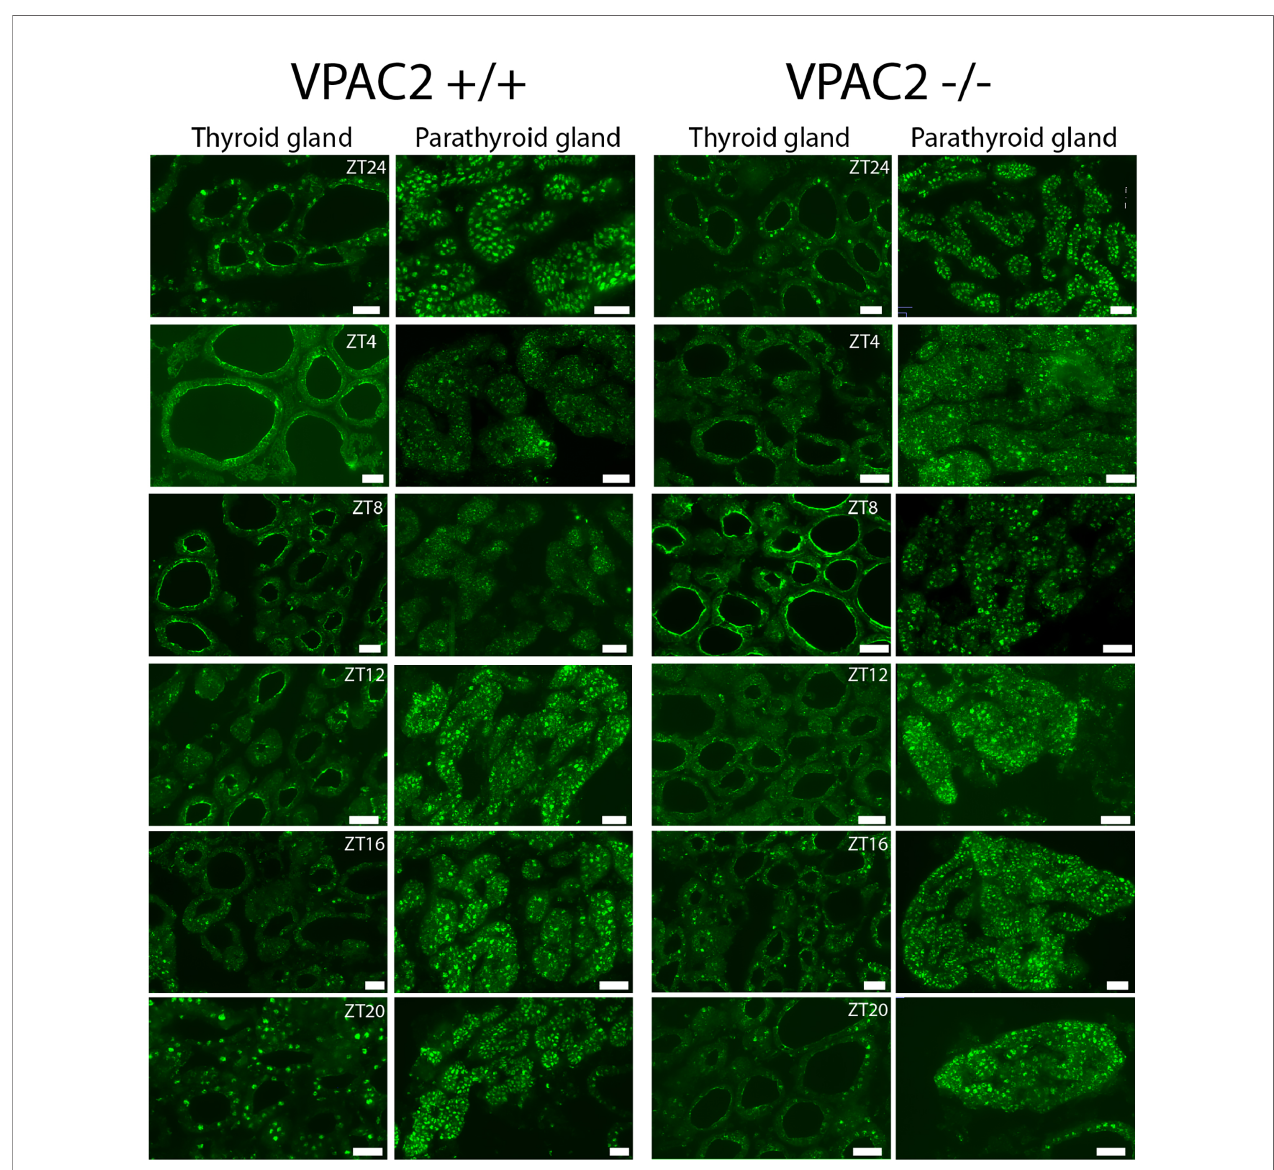
FIGURE 3 | Immunohistochemical staining of PER1 in the thyroid and parathyroid glands of VPAC2 wild-type and de fi cient mice during a 12:12 h light/dark periods. The two left rows show staining of the glands from wild-type and the two right rows staining of the knockout animals. PER1 is present in follicular cells in both the thyroid and parathyroid glands of both wildtype and VPAC2 de fi cient mice. Scale bars: 50